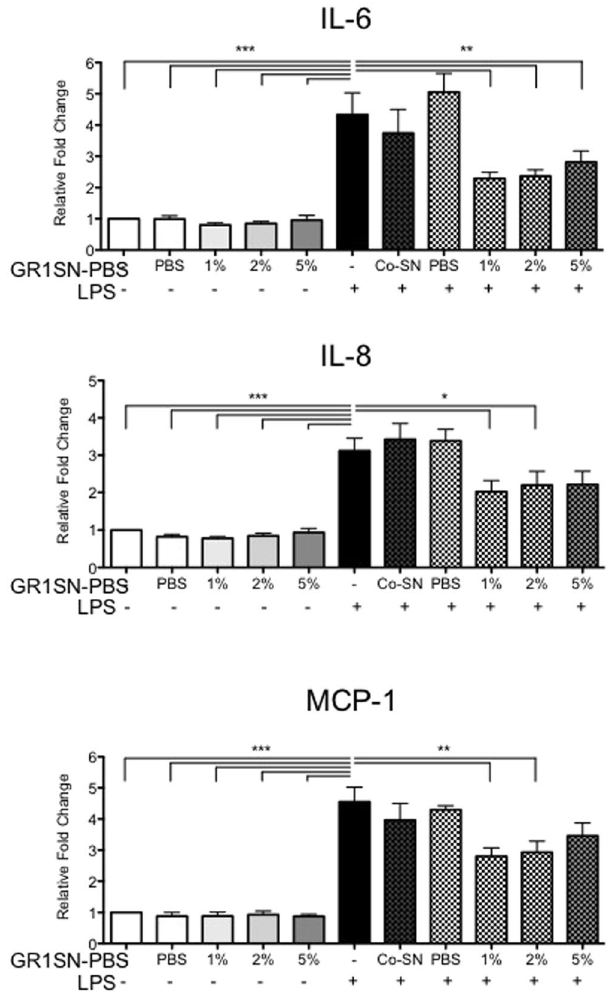
Figure 4. Effect of GR1SN-PBS treatment on hTERT-HM cell cytokine secretion following LPS stimulus. hTERT-HM cells were treated with PBS (1% v/v, “PBS”) or various doses of GR1SN-PBS (1, 2, 5% v/v) without LPS stimulus (solid grey bars), for 16 hours prior to (checkered grey bars), or concurrently with (GR1SN-PBS 1%, v/v, “Co-1%”) LPS (100 ng/mL). Values are presented as fold change (mean ± SEM) relative to untreated control (solid white bars). Statistical significance was determined by One-way ANOVA followed by Dunnett’s post-test relative to LPS stimulus (solid black bar). * P < 0.05; ** P < 0.01; *** P < 0.001 (n =